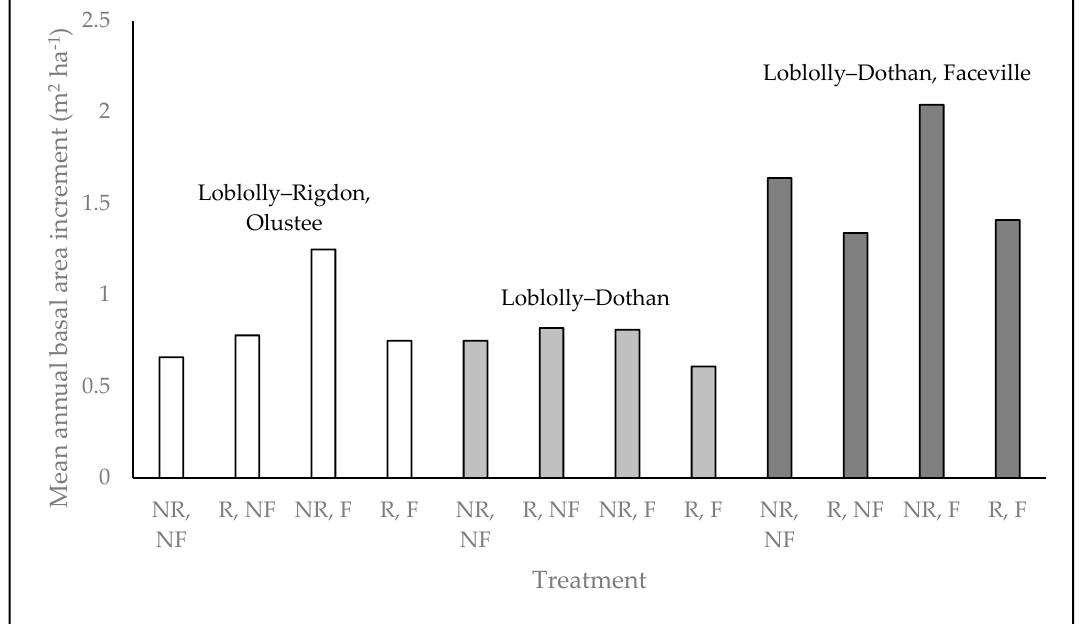
Figure 10. Mean annual basal area increment over the five-year study period for three loblolly pine sites by treatment [25]. Treatments: no rake, no fertilization (NR, NF); rake, no fertilization (R, NF); no rake, fertilization (NR, F); rake, fertilize (R, F) (refer to Tables 6 and 7 for study details, information on fertilizer treatments, and statistical test results).